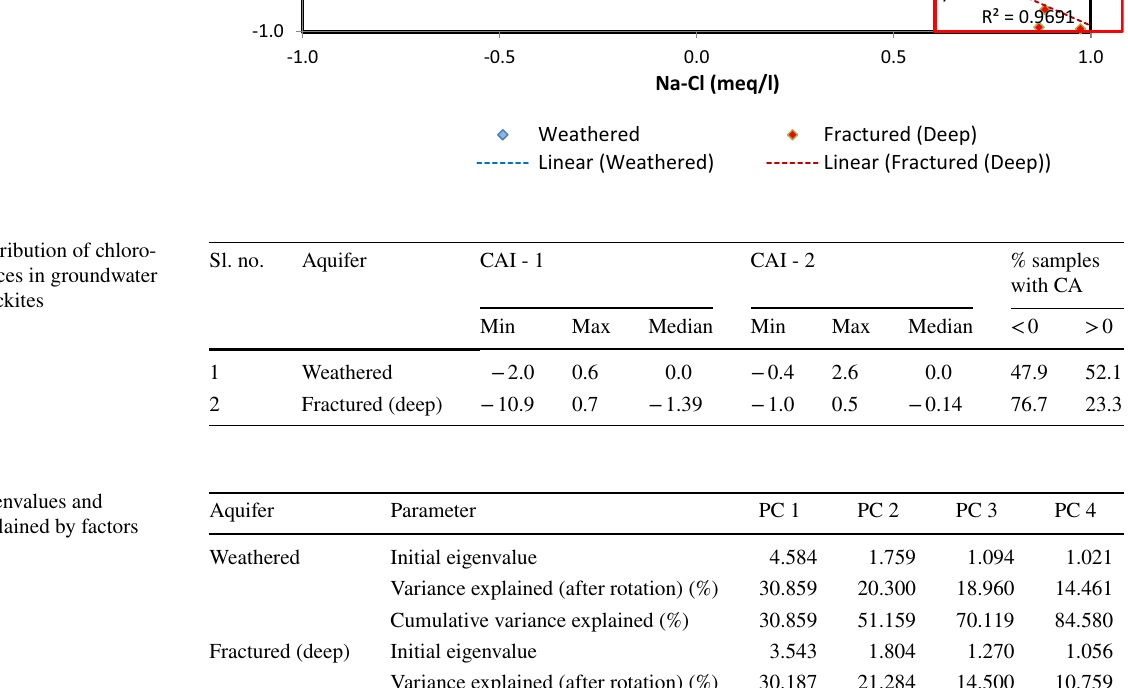
Fig. 12 Plots of Ca + Mg– HCO 3 –SO 4 versus Na–Cl